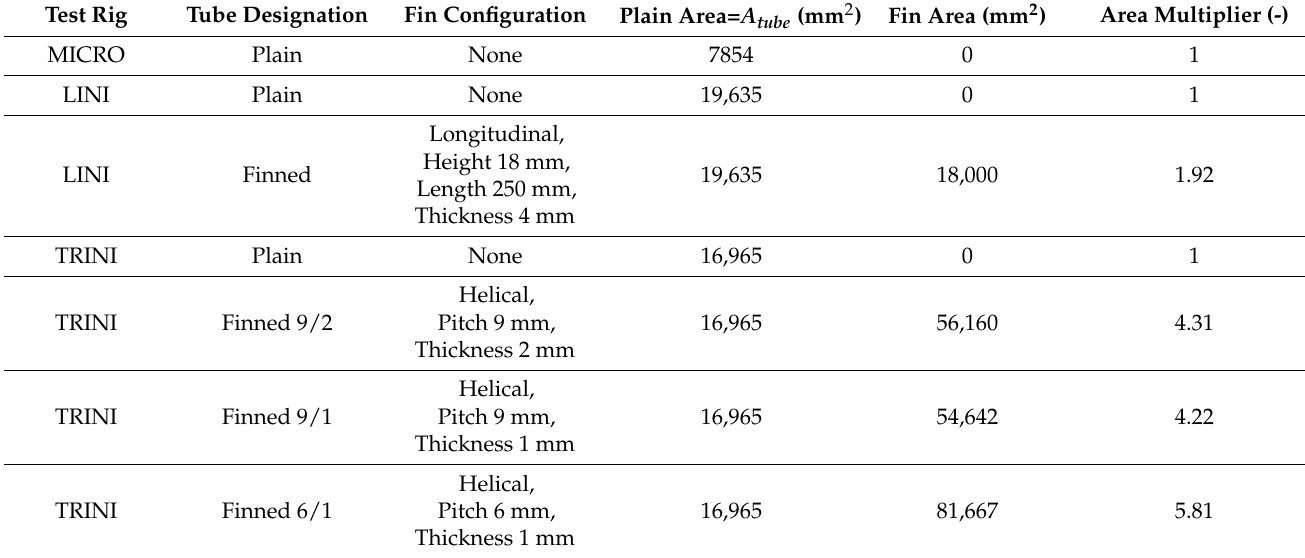
Table 1. Comparison of investigated tubes.